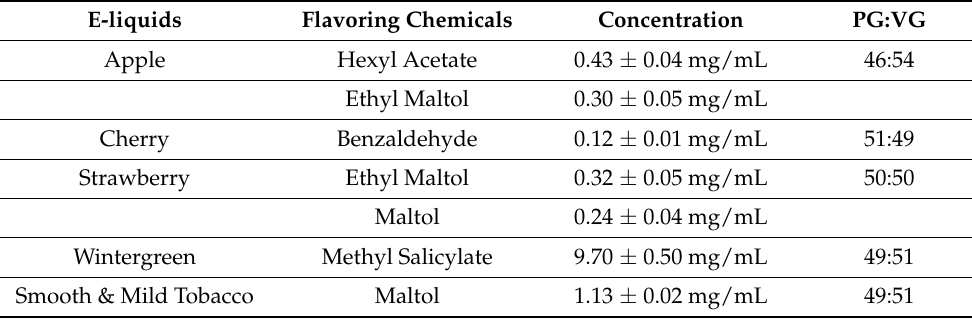
Table 1. Flavoring chemical and propylene glycol and vegetable glycerin quantification in e-liquids. 128 scans with a 4.7 s repetition rate and a 30 ◦ flip angle, with 64 k data points. Flavoring chemical concentrations and propylene glycol and vegetable glycerin quantification were representatives